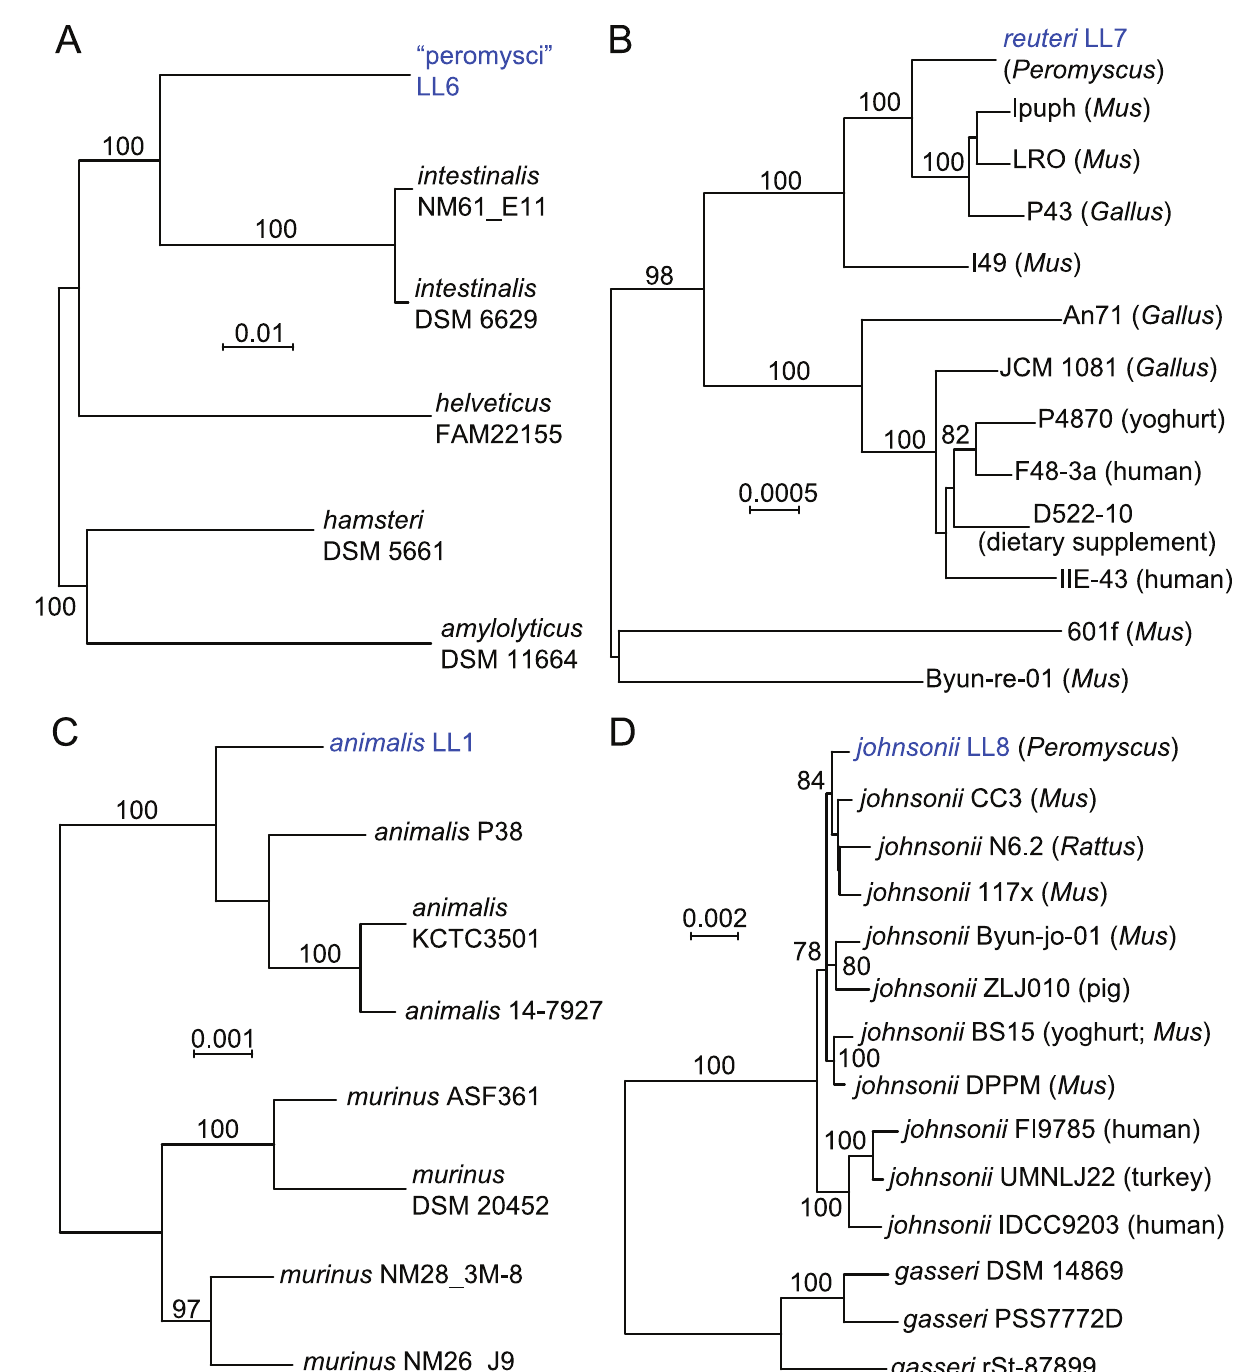
Fig 3. Neighbor-joining distance phylograms of codon-aligned, concatenated nucleotide sequences for complete sets of ribosomal proteins of “L. peromysci” (panel A), L . reuteri (panel B), L . animalis (panel C), and L . johnsonii (panel D) of P . leucopus compared with Lactobacillus spp. (strain identifier) of other sources. The scales for distance by Jukes-Cantor criterion are indicated in each panel. Percent bootstrap (100 iterations) support values of � 75% at a node are shown. In panels B and D the host animal or other origin for a given isolate are given in parentheses.